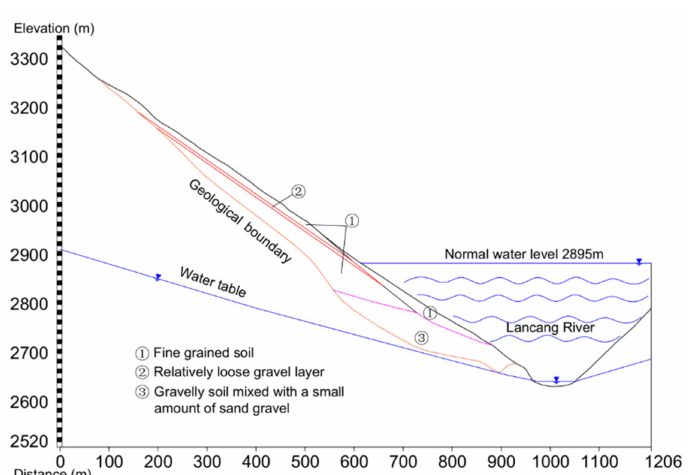
Figure 1. Location of the modeled accumulation layer.